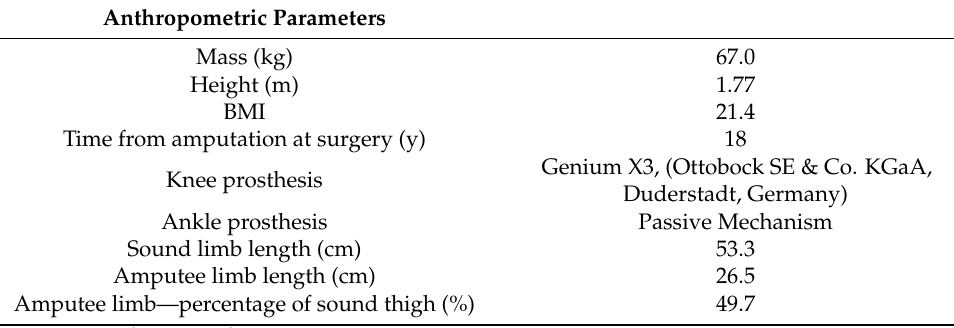
Table 1. Anthropometric parameters of the transfemoral amputee patient